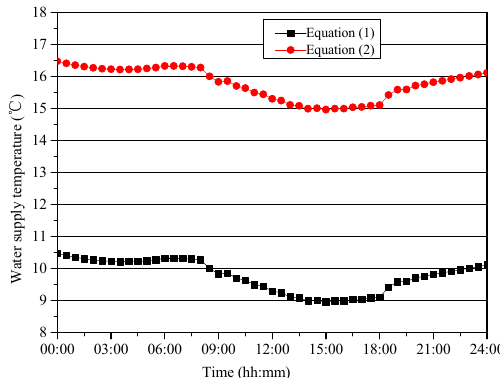
Figure 18. Variation trends of water supply temperature during a typical day.